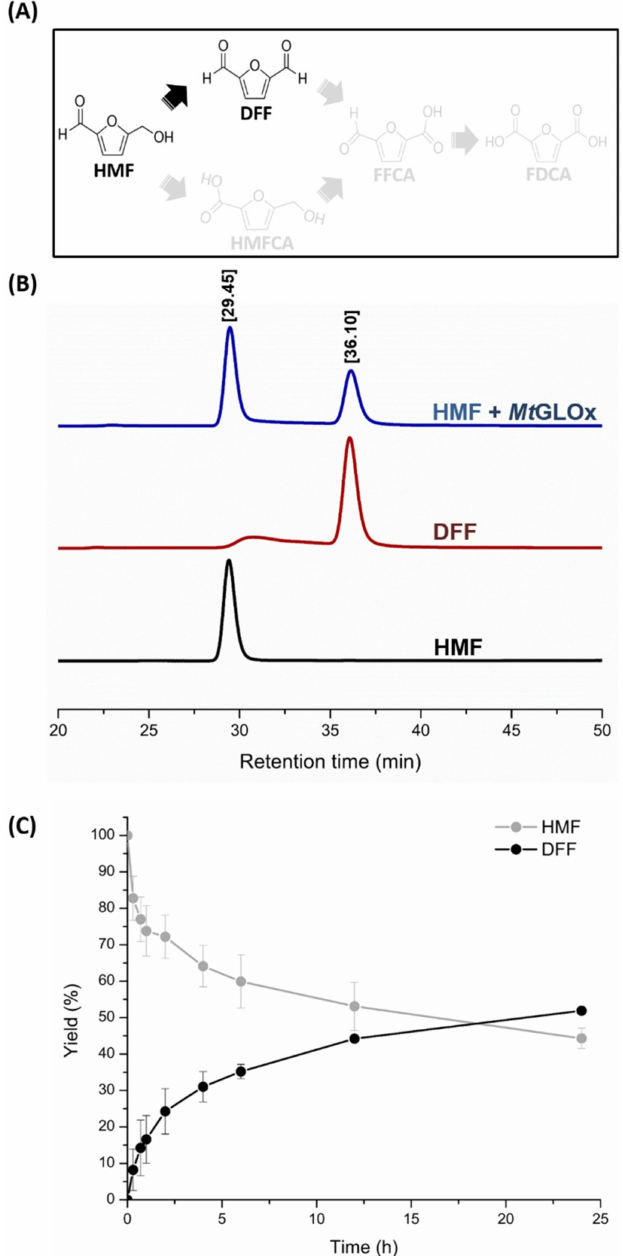
Figure 2. Pathway followed by Mt GLOx for hydroxymethylfurfural (HMF) oxidation. ( A ) Representation of possible pathways of hydroxymethylfurfural (HMF) oxidation and products. Mt GLOx oxidizes HMF only to 2,5-dimormylfuran (DFF) (black path). ( B ) High Performance Liquid Chromatography (HPLC) chromatograms of the products generated from HMF oxidation. Blue line: product generated from HMF oxidation. Red and black lines: DFF and HMF standards, respectively. Reaction mixture were incubated for 24 h (blue). ( C ) Time course reactions were monitored for oxidation of 1 mM HMF to DFF by 0.5 µ M Mt GLOx. Standard deviations are shown by error bars (n =